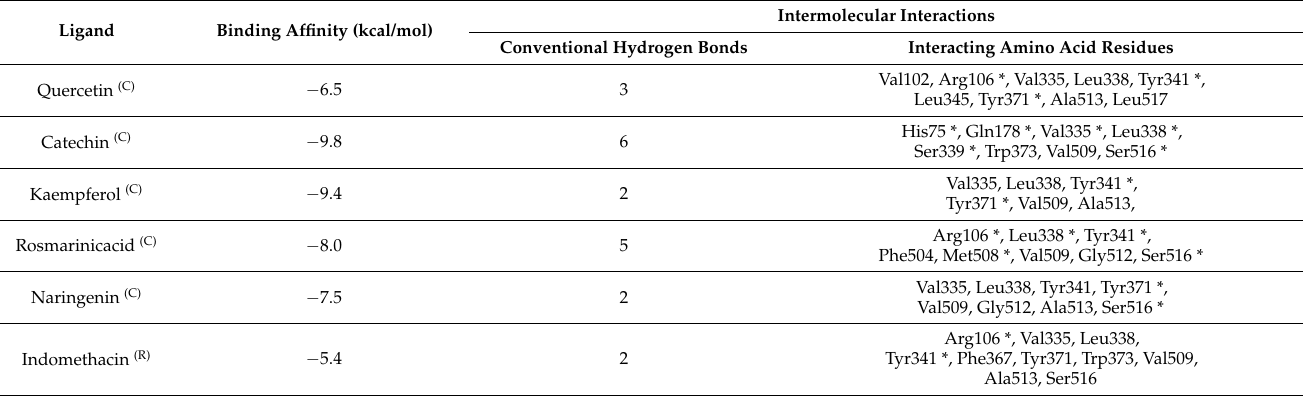
Figure 4. Photomicrographs of paw tissues from the studied groups. The control rats treated with physiological saline (NaCl, 0.9%) showed normal histological structure of both epidermis and dermis; FOR group received formalin 2% showed cumulative edema with massive infiltration of inflammatory cells and paw edema; FOR+CA and FOR+INDO groups treated with CA and INDO, respectively, showing very weak inflammatory reaction once compared with FOR group. Ep: epidermis, Der: dermis: inflammatory cells infiltration; edema. Table 6. The ligands and COX-2 interactions: binding affinity, number of conventional hydrogen bonds and interacting amino acid